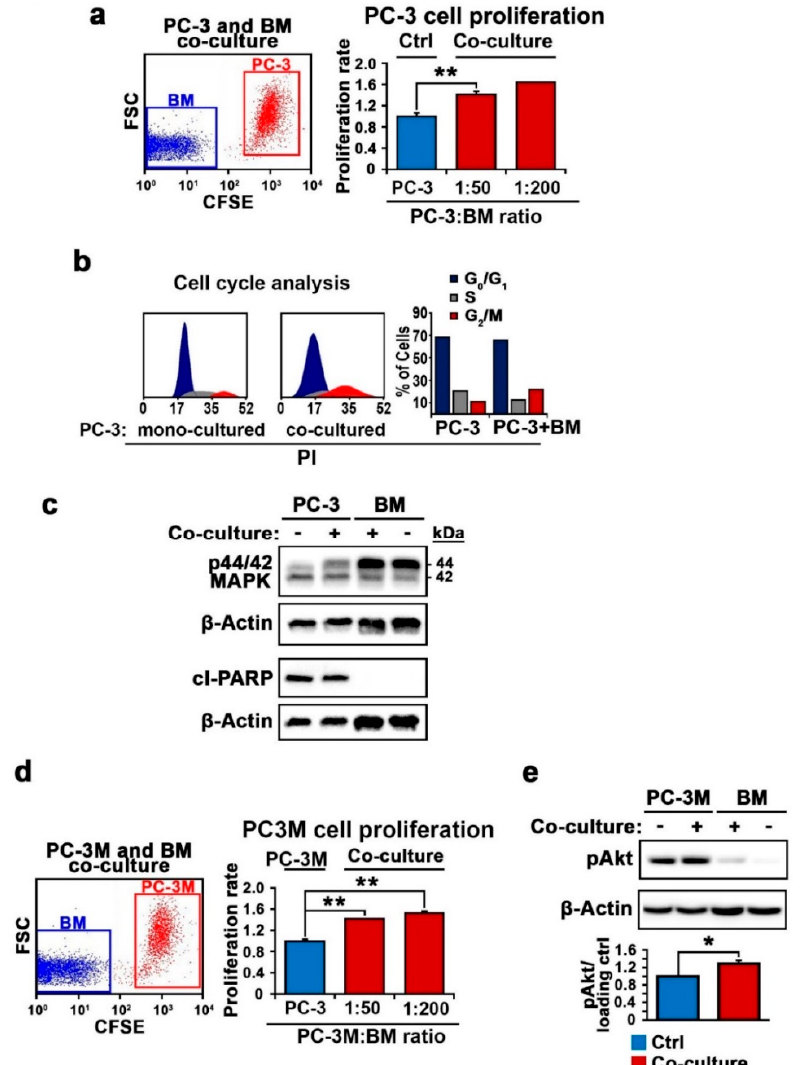
Figure 1. The effect of bone marrow cells on the proliferation of prostate cancer (PCa) cells. ( a ) The effect of the bone marrow cells on the proliferation of the PC-3 cells was determined using flow cytometry analysis. Representative fluorescence-activated cell sorting (FACS) plots show the separation of PC-3 and bone marrow cell (BM) populations in the left panel. The ratios between the PC-3 cells and mouse primary BM are indicated. For a ratio of 1:50 (PC-3/BM), the mean proliferation rate of the mono-cultured control PC-3 cells is set as 1, The p -value indicates the difference in proliferation between the PC-3 cells from the mono-culture and those from the co-culture. ** p = 0.002. ( b ) Cell cycle analysis of PC-3 cells from the mono-culture or co-culture was performed using flow cytometry analysis. Representative FACS histogram is shown in the left panel. The bar chart shows the distributions of the proportions of PC-3 cells at each cell cycle phase. ( c ) Immunoblot analysis of PC-3 cells vs. BM from the mono-cultured controls or co-cultured counterparts was performed using antibodies against MPAPK phor44/42, cleaved PARP and β -actin as loading controls. PC-3 cells vs. BM were collected from the same co-culture after co-culturing for 48 h at a ratio of 1:150 (PC-3/BM). ( d ) The effect of the bone marrow cells on the proliferation of PC-3M cells was determined using flow cytometry analysis. Representative FACS plots show the separation of PC-3M and BM cell populations in the left panel. Bar chart shows the PC-3M cells after 48 h of mono-culture or co-culture with BM at ratios of 1:50 and 1:200 (PC-3M/BM). For both ratios, p < 0.001 as indicated with “**”. Data are presented as averages of three experiments. ( e ) Expression of pAKT was determined by immunoblot analysis. Mean expression of pAKT in mono-cultured PC-3M cells was set as 1, and in co-cultured PC-3M, it was 1.29; difference = 0.29; 95% CI = 1.16 to 1.43; p = 0.049. * p < 0.05. ** p < 0.01. Data are presented as averages of three experiments.